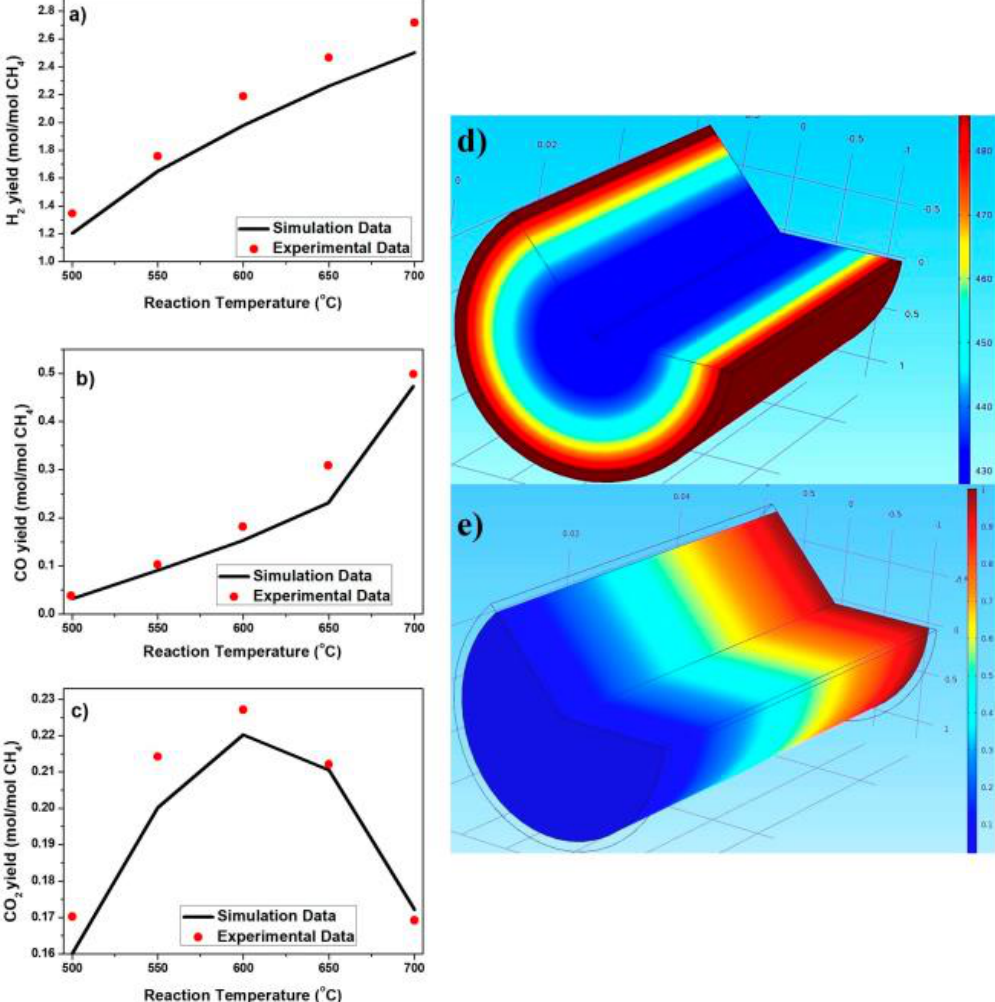
Figure 1. Validation of experimental results with the simulation data for 10% Ni/Al 2 O 3 catalyst within 500–700 °C and S/C of 2 under atmospheric pressure; ( a ) H 2 yield, ( b ) CO yield, ( c ) CO 2 yield, ( d ) Catalyst bed temperature distribution, and ( e ) H 2 pressure distribution [62].